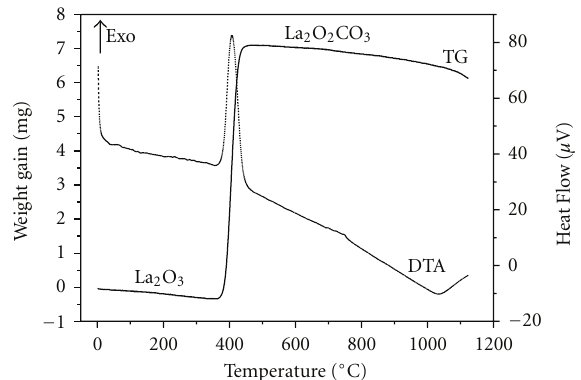
Figure 2: Evolution of La 2 O 3 weight during cooling process, under CO 2 flow: formation of La 2 O 2 CO 3 phase (exothermic peak) then relative stabilization of this phase as temperature decreases.